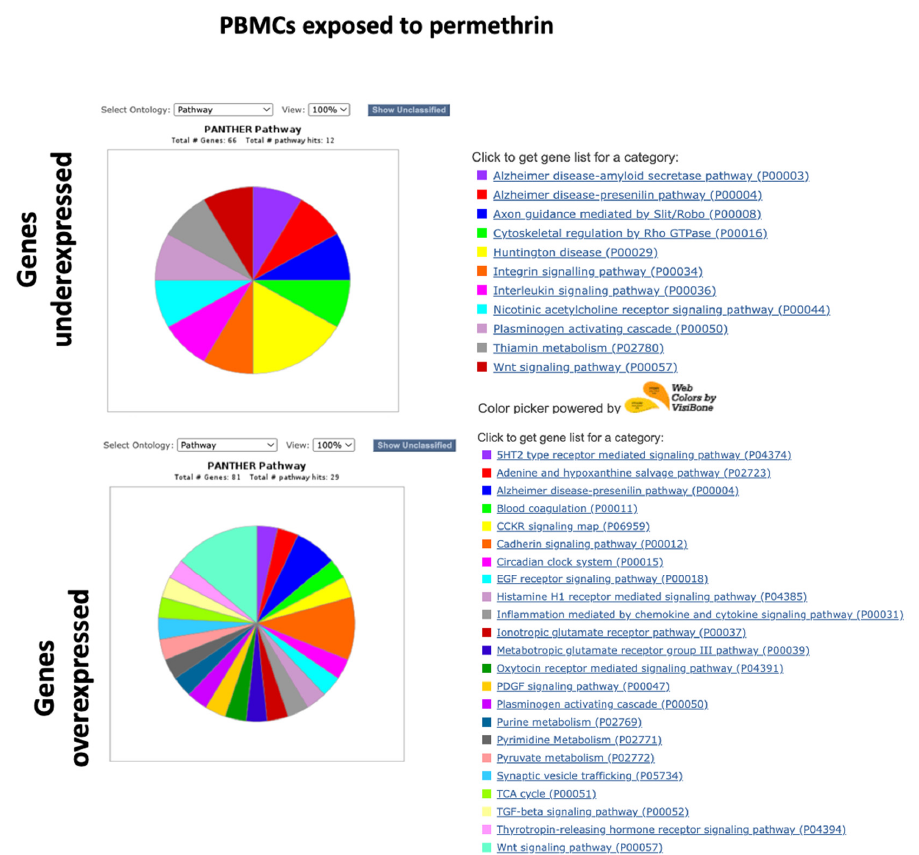
Figure 8. Pathway ontology analyisis in PBMCs exposed to